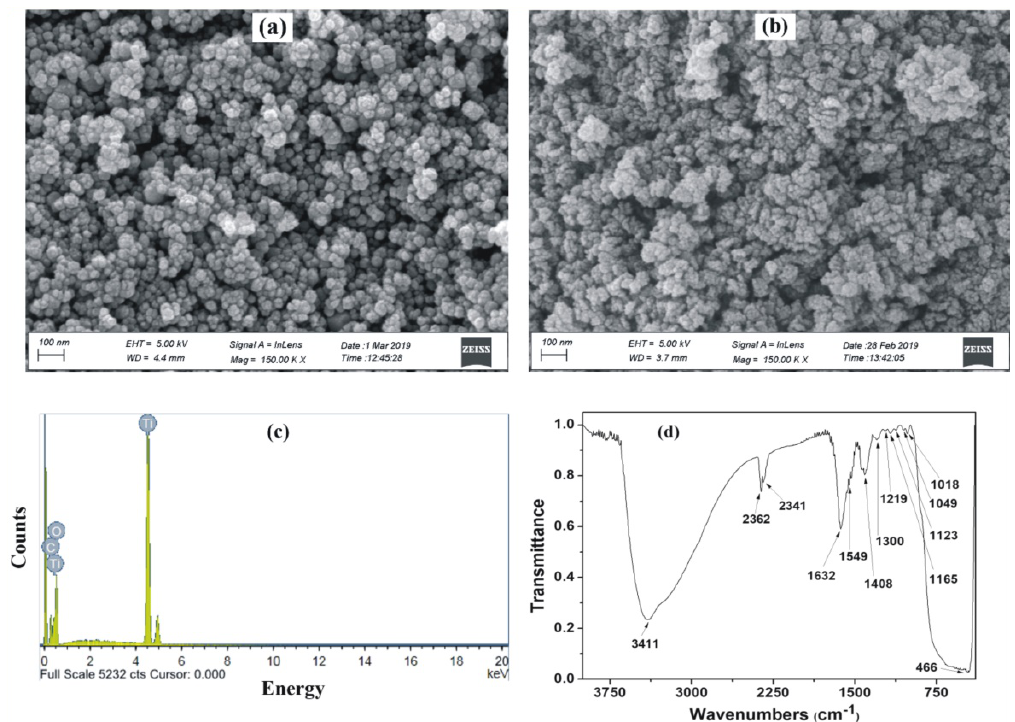
Fig. 1. (a) FE-SEM of TiOSA, (b) FE-SEM of TiOSA after Cu (II) adsorption (c) EDX of TiOSA, and (d) FTIR spectrum of